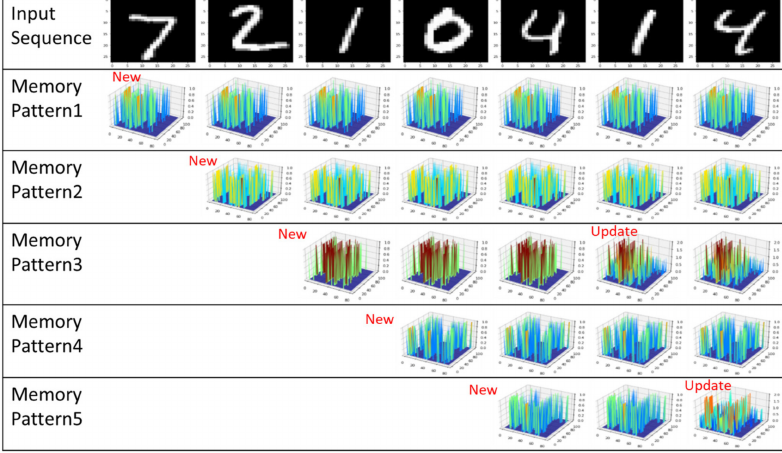
Figure 15. An example of forming an initial memory pattern without a pre-memory